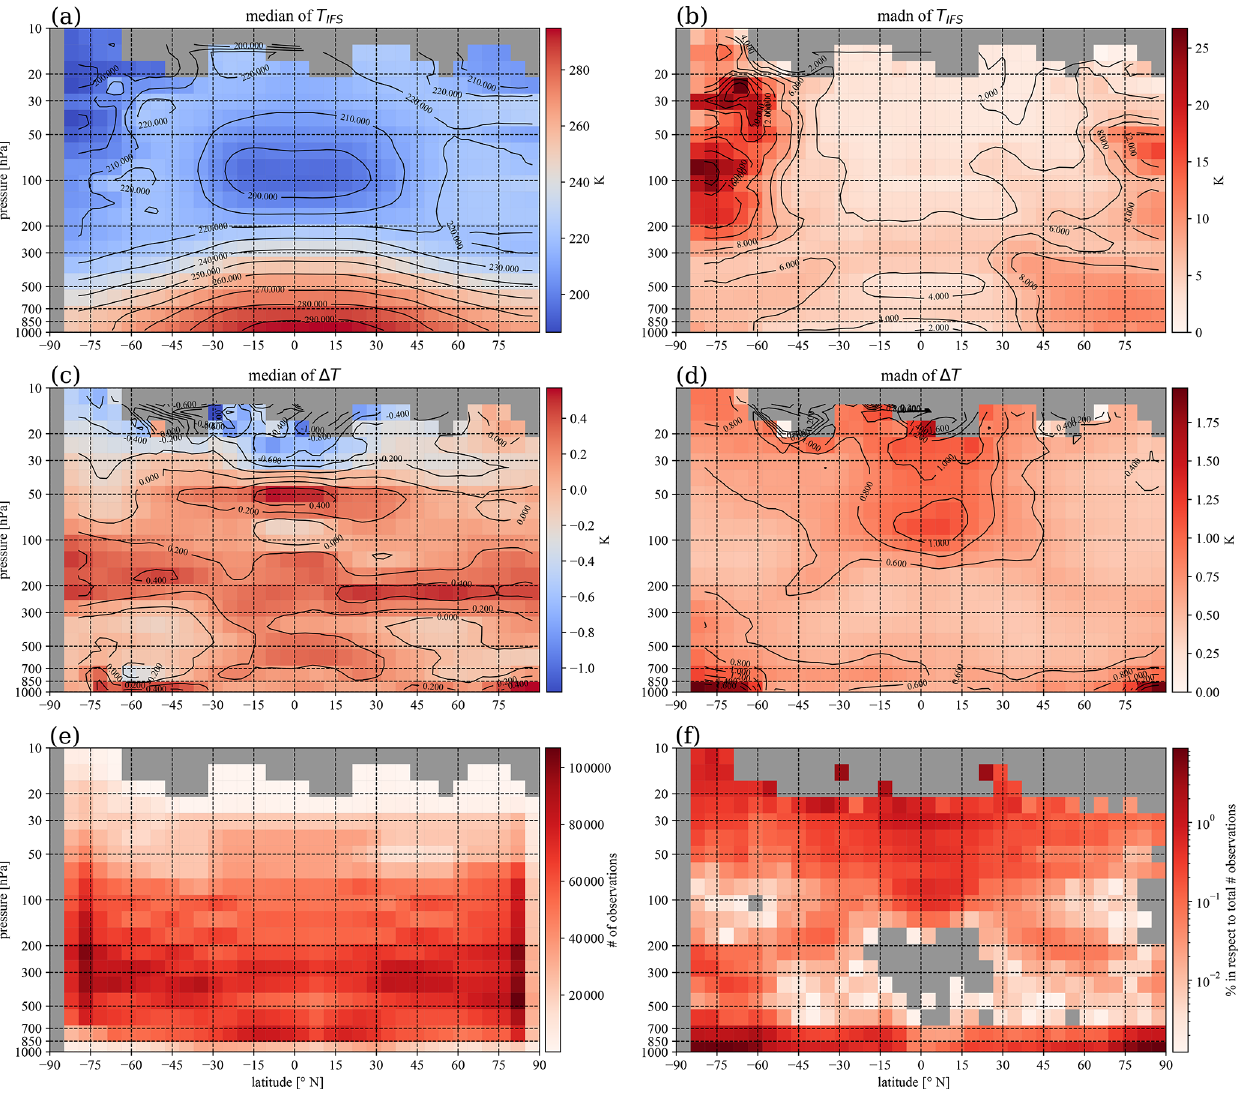
Figure 5. The zonal and temporal statistics of the IFS temperature (a, b) and temperature differences between ARPEGE and IFS (c, d) computed for the same period as in Figs. 3–4. (a, c) The median and (b, d) madn = 1 . 48mad are shown. In addition panel (e) shows the associated number of data for the statistics and (f) the number of samples found with a temperature difference (cid:49)T > 4K used in the discussion of the Fig.